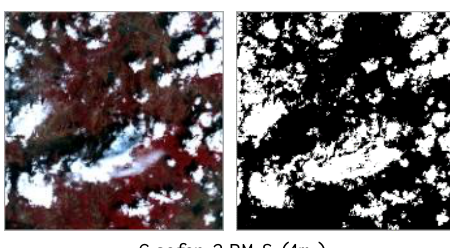
Figure 4. Cloud detection results of MSCN and MFC.